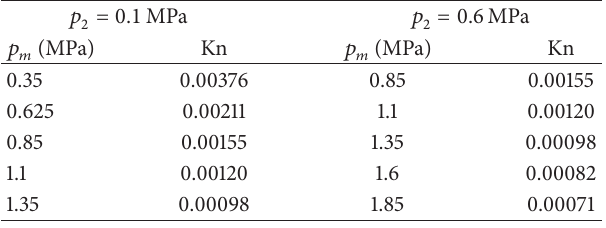
Table 4: Knudsen number at different pressure for sample SS-3. 𝑝 = 0.1 MPa 2